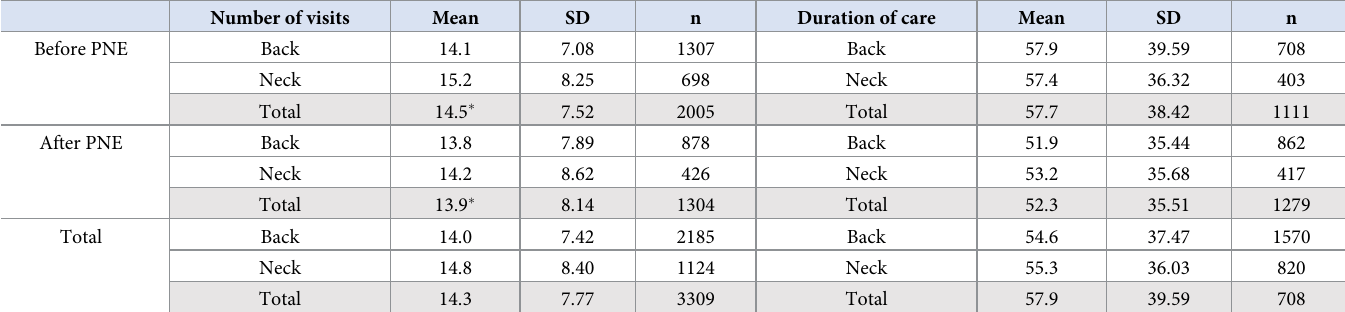
� Indicates statistically significant